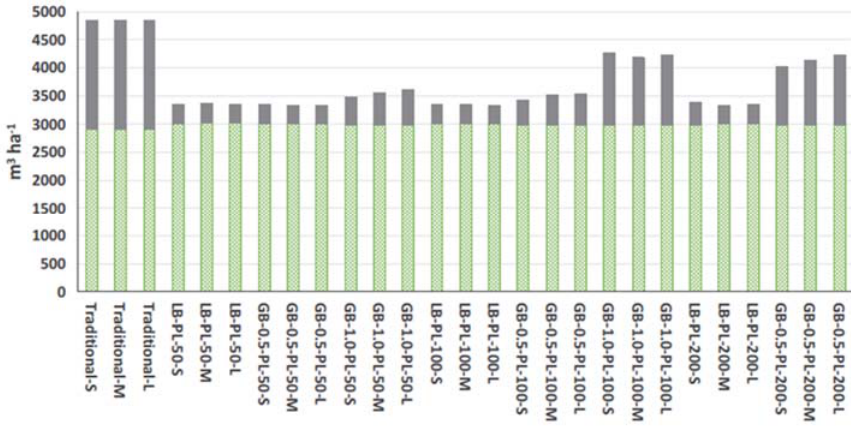
Figure 5. Beneficial and non-beneficial water use (BWU and NBWU , m 3 ha − 1 ) relative to summer irrigation in a medium infiltration soil and considering level basins (LB) and graded basins (GB) with slopes of 1.0‰ and 0.5‰, with precise land levelling (PL); lengths of 50, 100, and 200 m; and inflow rates S, M, and L (defined in Table 7).